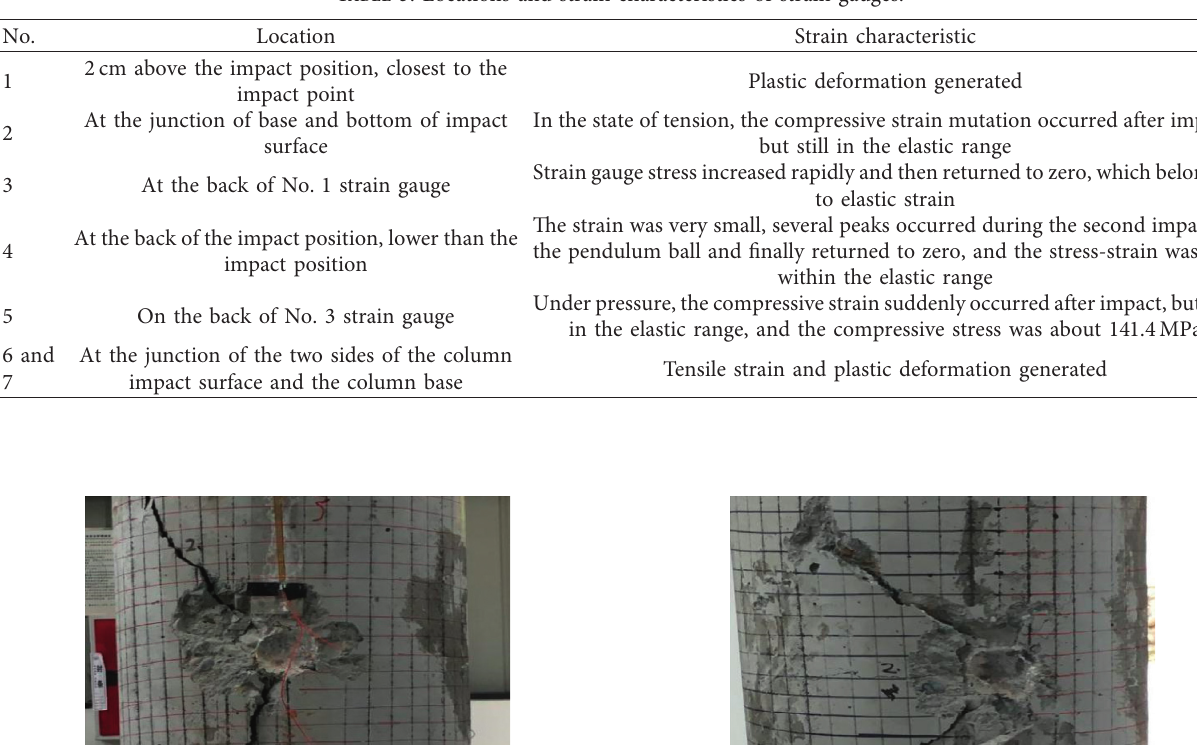
Table 5: Locations and strain characteristics of strain gauges.